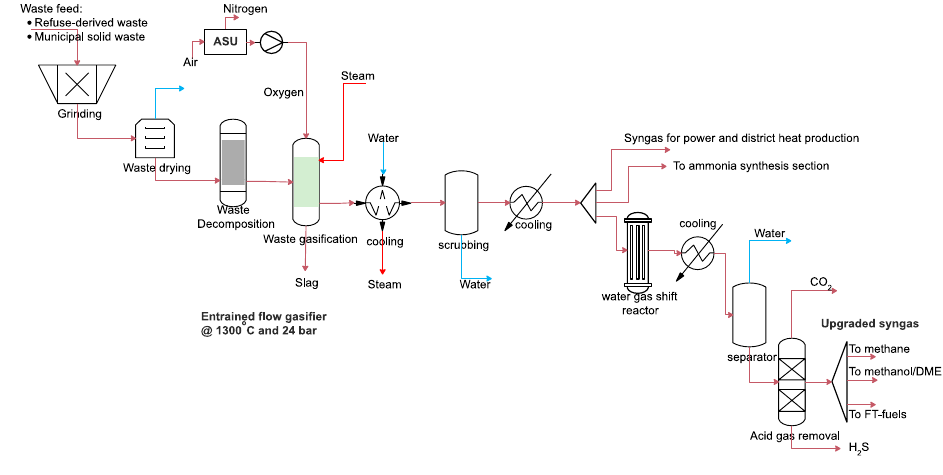
Figure 2. Process flow diagram of entrained flow gasification of MSW and RDF.